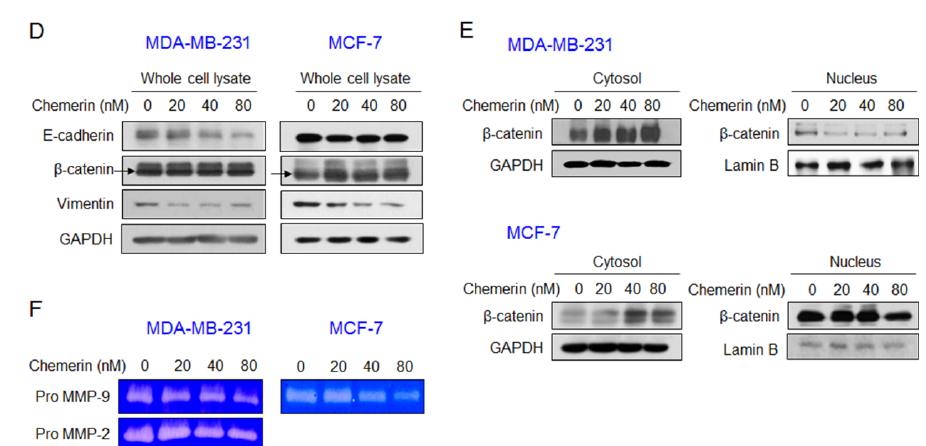
Figure 1. Chemerin suppressed the viability, invasion, and epithelial–mesenchymal transition (EMT) of breast cancer cells. ( A , B ) The viability, migration, and invasion of ( A ) MDA-MB-231 or ( B ) MCF-7 breast cancer cells treated with